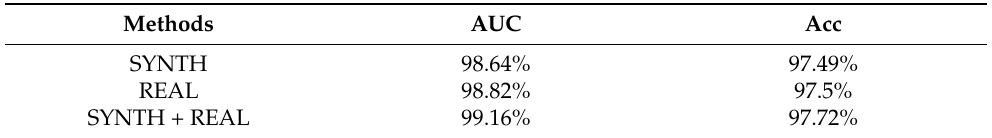
Table 3. Segmentation performance using the generated and real images from the CHASE_DB1